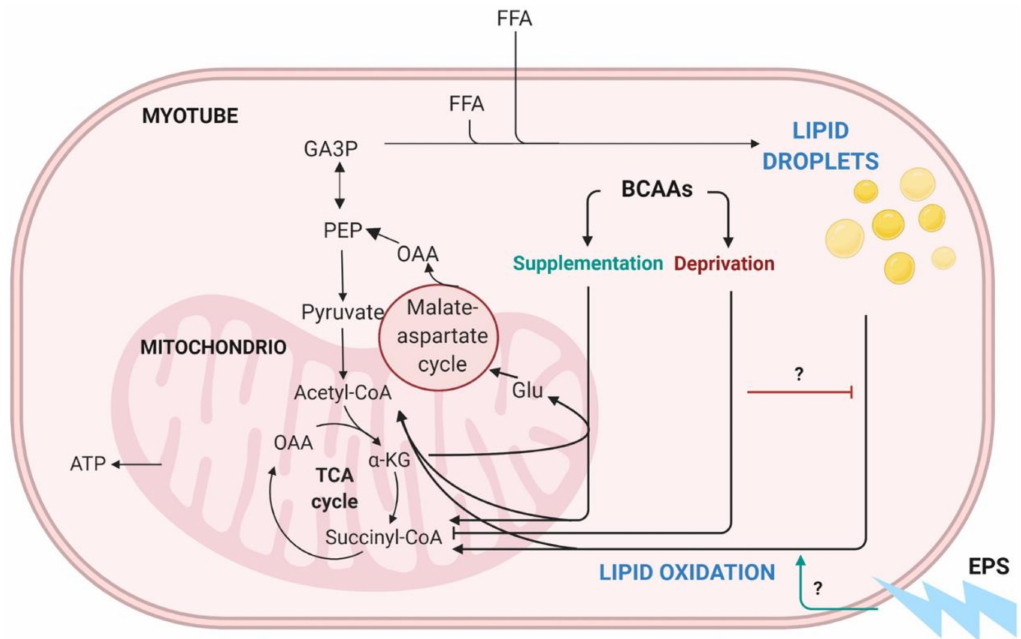
Figure 1. Schematic presentation of BCAA catabolism, lipid oxidation and lipogenesis in skeletal muscle. BCAA = branched-chain amino acid, EPS = electrical pulse stimulation, TCA = tricarboxylic acid cycle, OAA = oxaloacetate, CoA = coenzyme A, ATP = adenosine triphosphate, α KG = α -ketoglutarate, Glu = glucose, PEP = phosphoenolpyruvate, GAP3 = glyceraldehyde-3-phosphate, FFA = free fatty acid. Modified from Kainulainen et al., 2013 [3]. Figure was created with